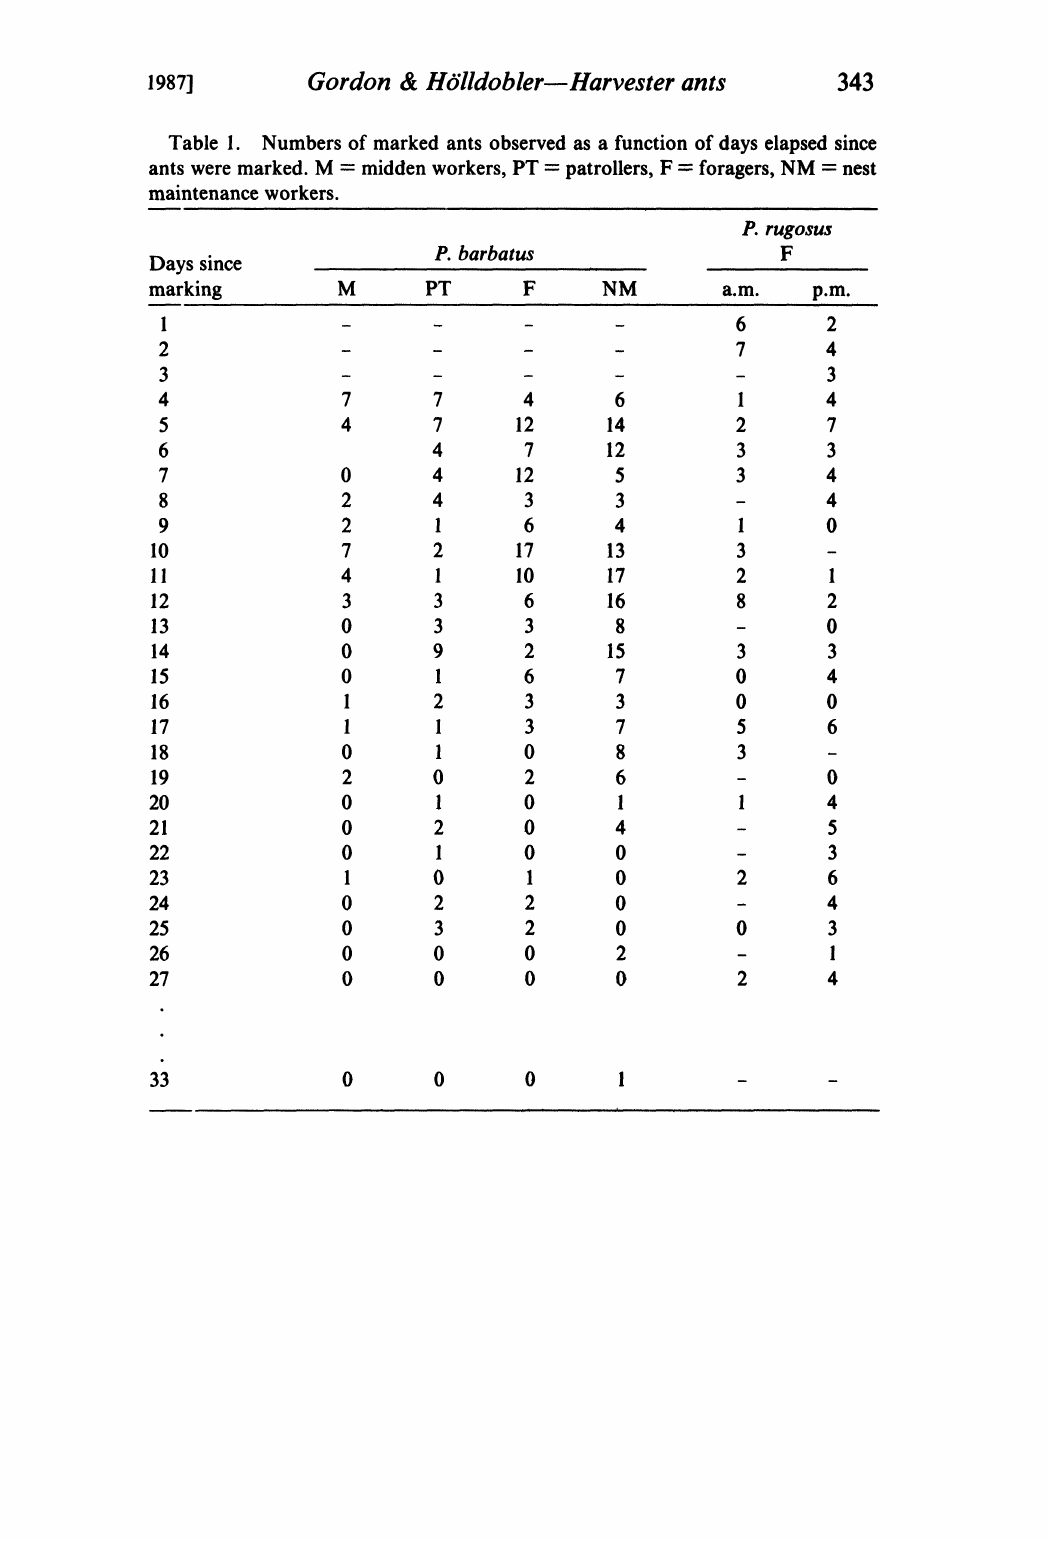
Table 1. Numbers of marked ants observed as a function of days elapsed since ants were marked M midden workers, PT patrollers, F foragers, NM nest maintenance workers Days since P.